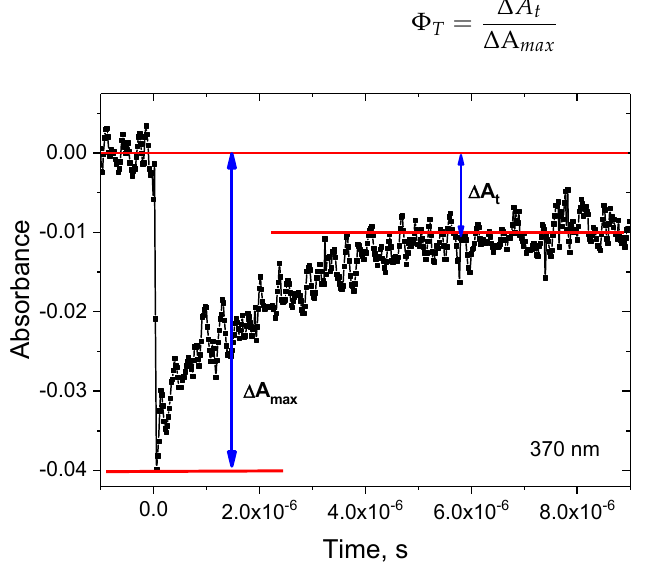
Figure 6. Analysis of Δ A(t) curve recorded for FN2 in acetonitrile at 370 nm.